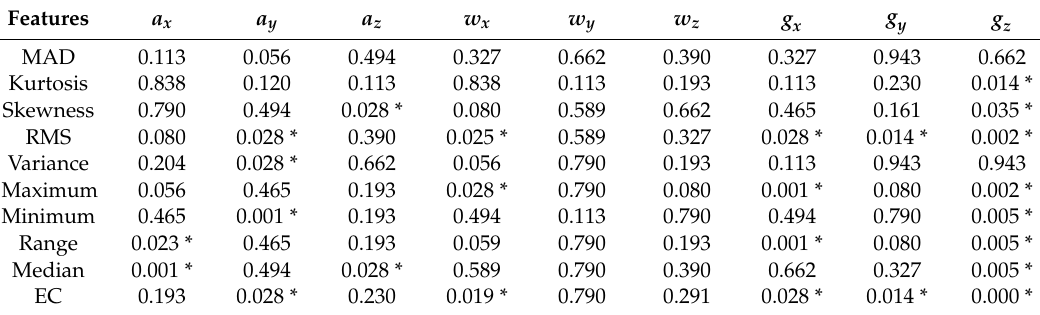
Table 2. The Friedman test results of three time periods for each parameter.